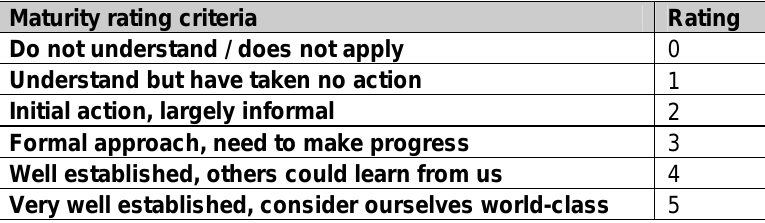
Table 2: Maturity rating scale as used in this